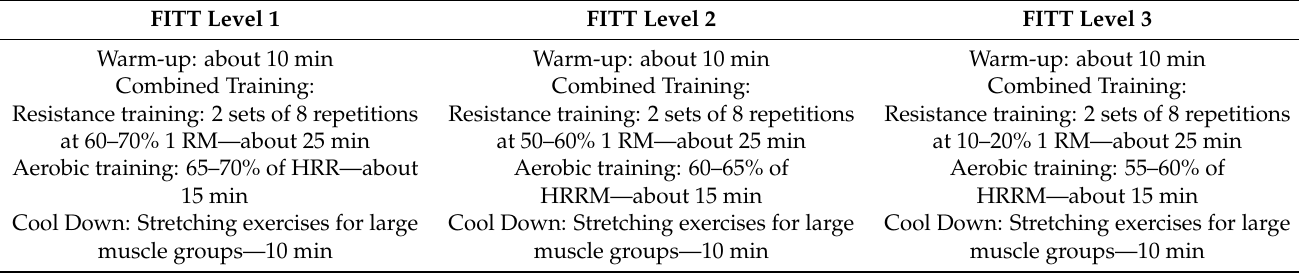
Table 2. FITT (Frequencies, Intensity, Time, Type) prescription according to the risk levels. Abbrevia- tion: 1RM = one Repetition Maximum; HRR = Heart Rate Reserve; min =